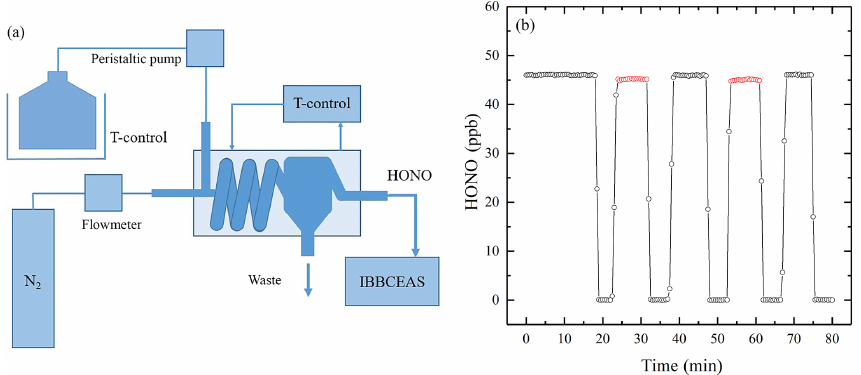
Figure 5. (a) The schematic of HONO standard generator. (b) Black circles correspond to observed [HONO] from the HONO standard generator; red circles correspond to the measured [HONO] with the extra 1m PTFE filter, 3m PFA inlet tube and the simulative PFA optical cavity tube added in front of the IBBCEAS